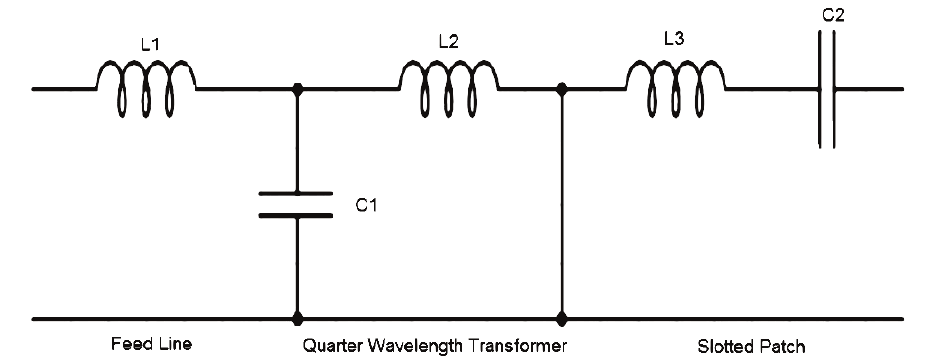
Fig. 4. The circuit equivalent of the projected